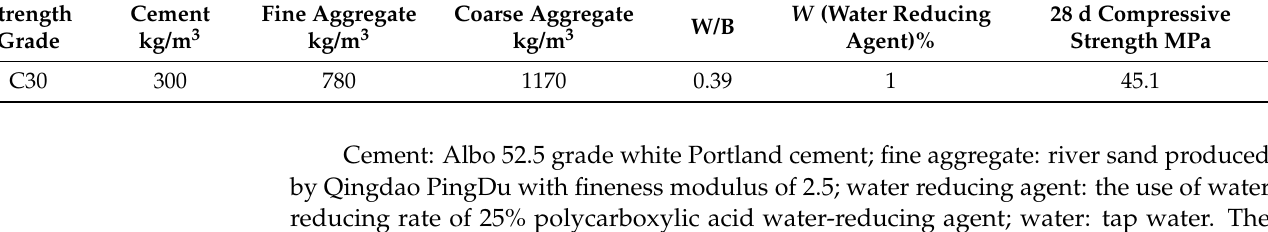
Figure 2. Grain composition. Table 1. The original concrete mixture ratio.